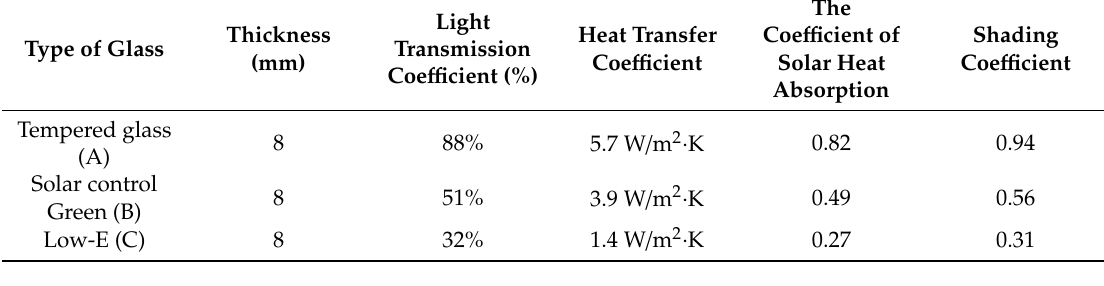
Table 5. Main specifications of the three types of glasses.